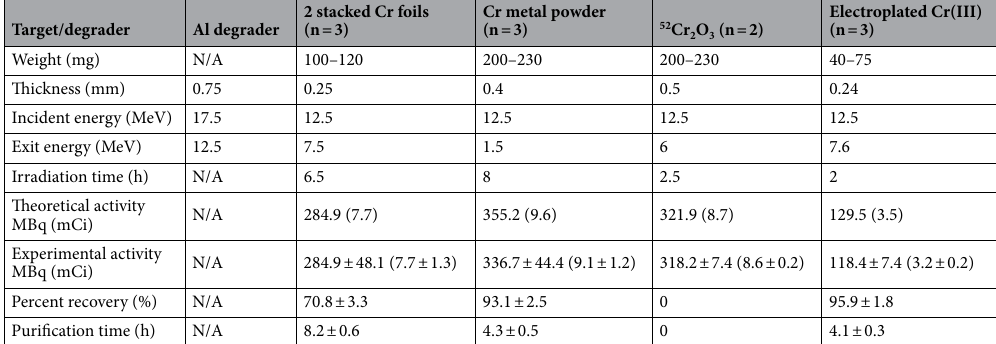
Table 4. Target configuration and radioactivity before purification and purification yield results with variable currents and irradiation times.